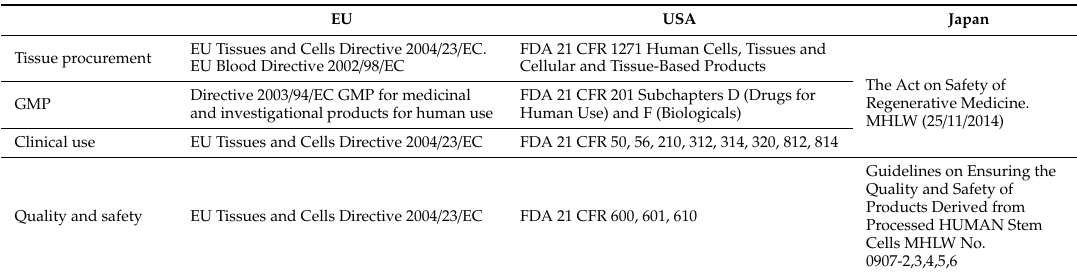
Table 2. Current legislation concerning the production of cell-based